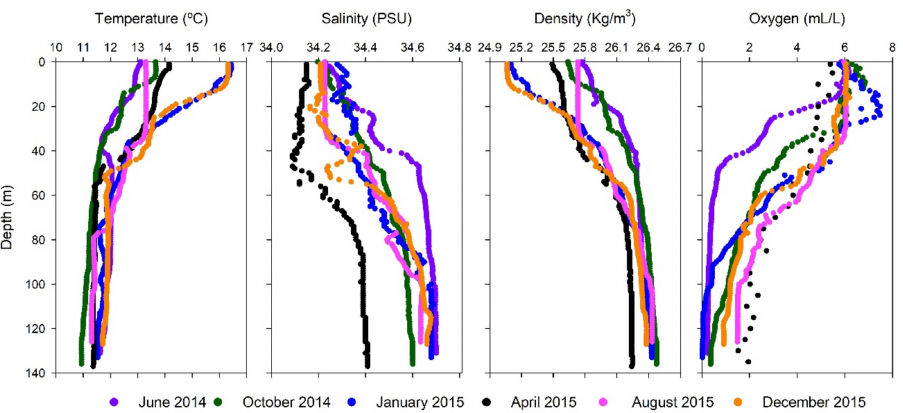
Figure 1. Temperature, salinity; density; and oxygen distribution in the water column from selected months during the 2014 and 2015 oceanographic